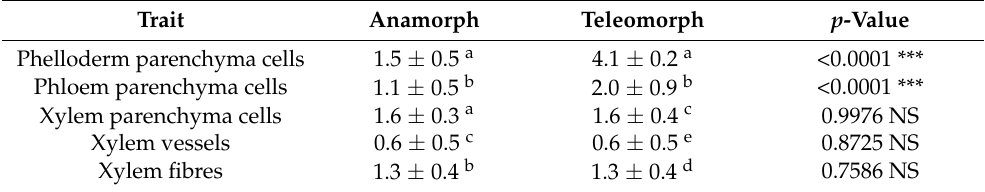
Table 2. The width of fungal hyphae (in µ m) inside periderm, phloem and xylem tissues.